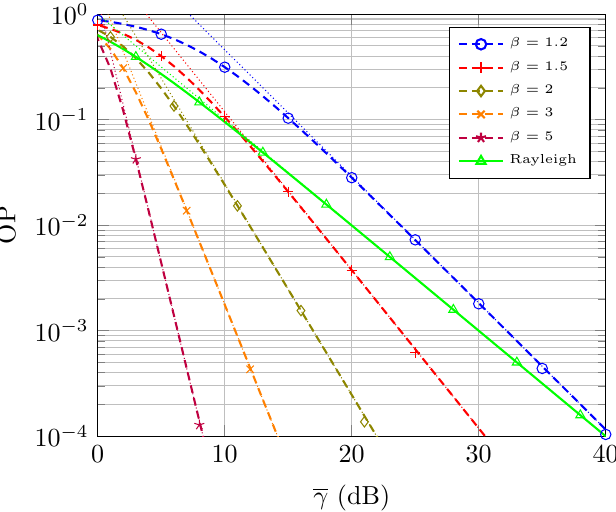
Figure 3. Outage probability vs. γ under L -distributed fading for different values of β . Solid lines cor- respond to the theoretical expressions in (9). Dashed lines correspond to the asymptotic expressions in (10). The case of Rayleigh fading is included as a reference. Markers denote MC